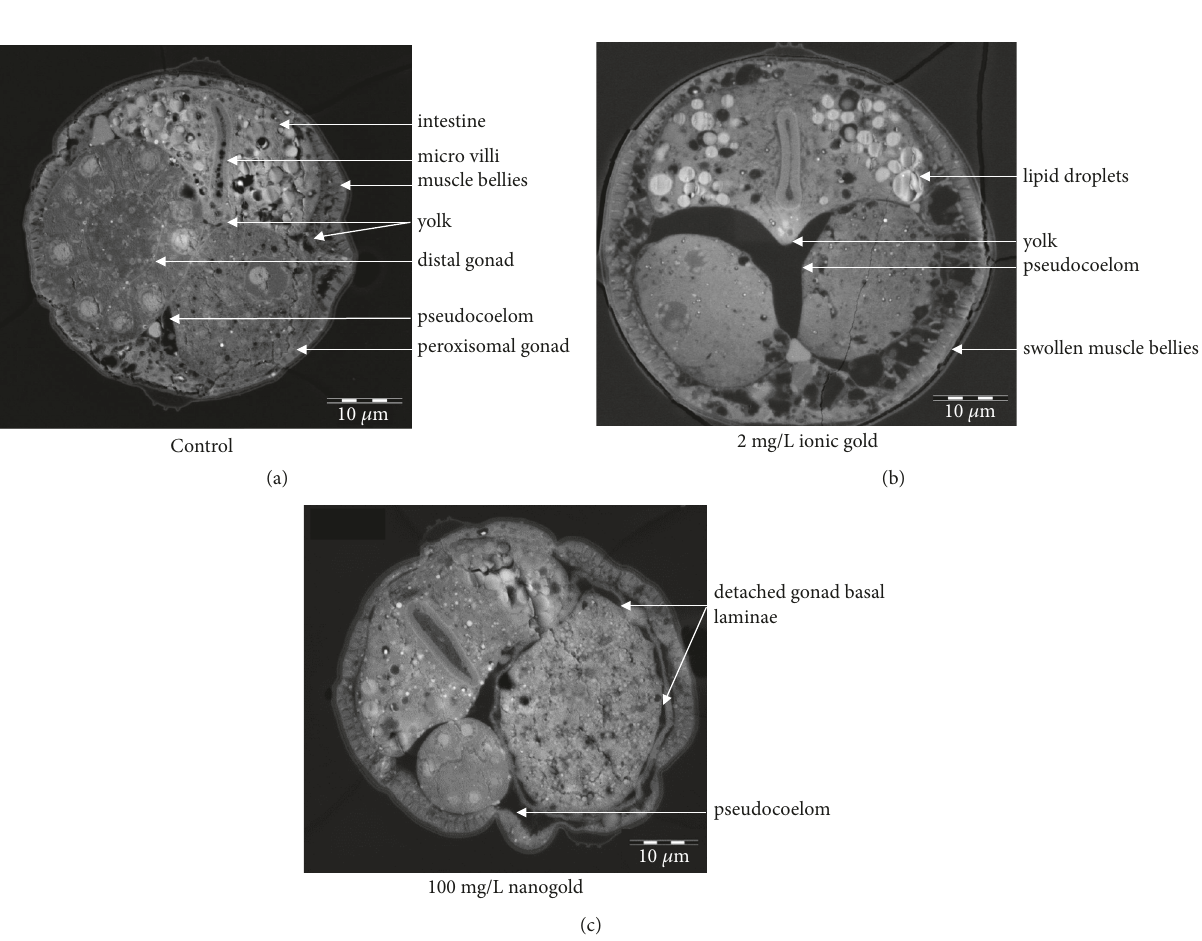
Figure 3: Scanning electron micrograph images of cross-sections of C. elegans exposed to the highest concentrations of ionic (b), nanogold (c), and control (a). Table 3: Effect concentration (mg/L) values of nanogold and its bulk chemical equivalent. Toxicity parameters with upper and lower confidence Au